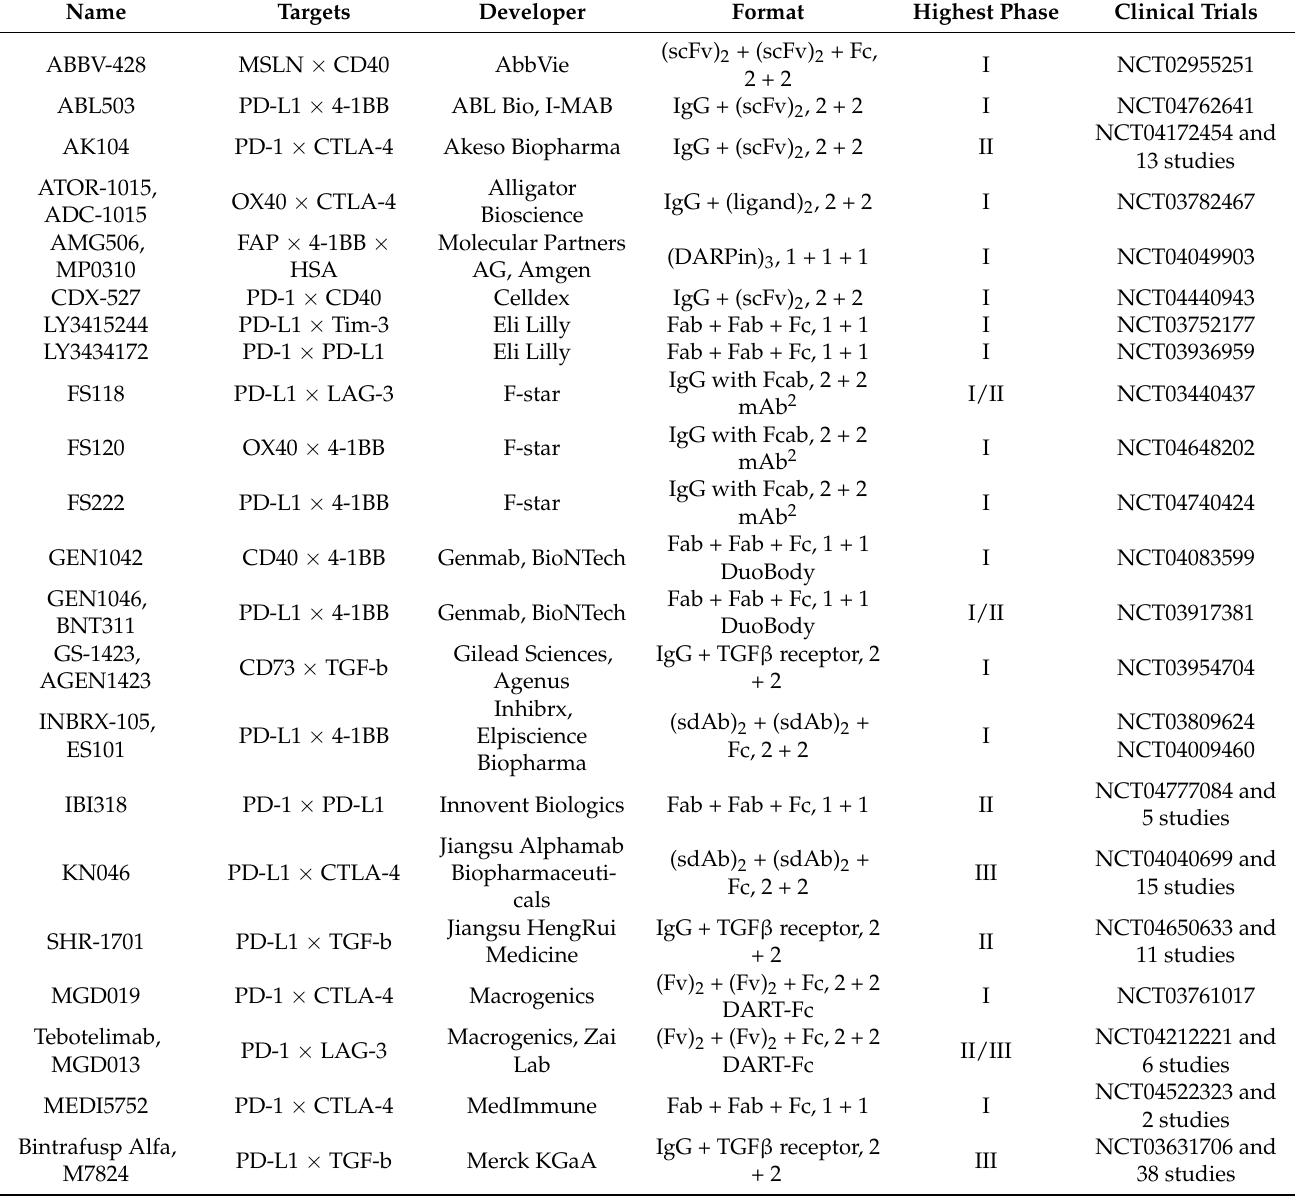
Table 3. Tumor-targeted or Dual immunomodulators in clinical